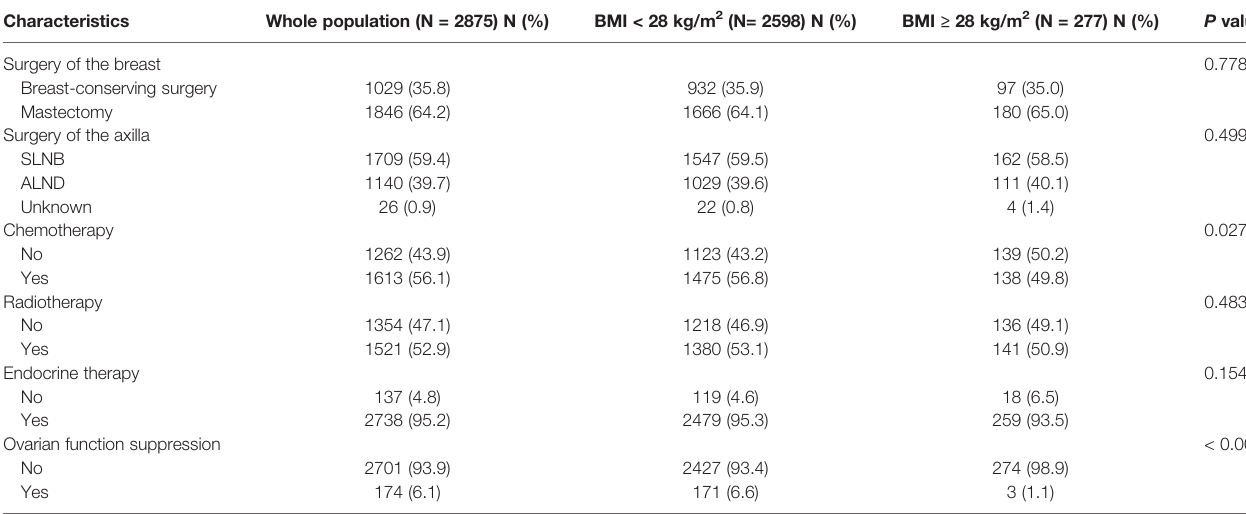
TABLE 2 | Distribution of treatment in the whole population and different BMI groups. Characteristics Surgery of the breast